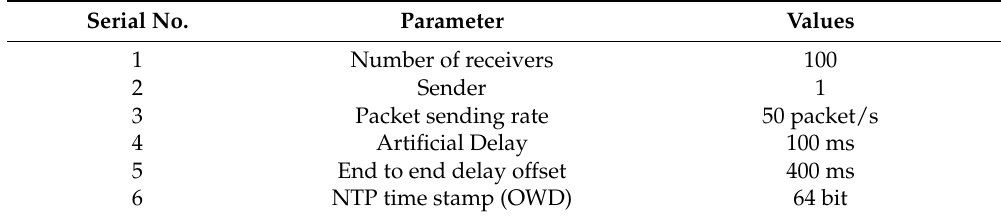
Table 2. Implementation of setup parameters.